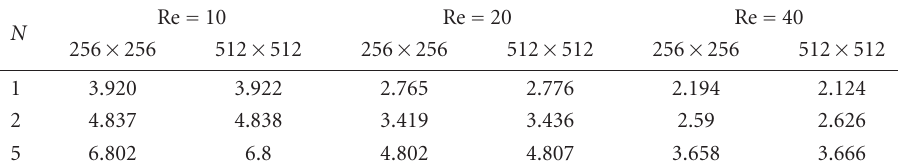
Table 4 . 2 . Comparison of second-order accurate drag coe ffi cient values obtained in 512 × 512 and 256 × 256